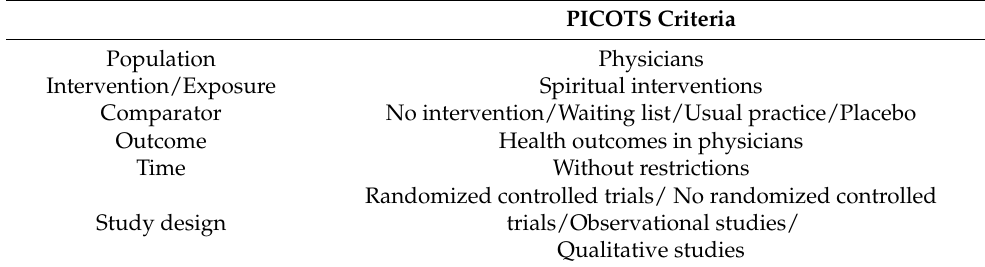
Table 2. PICOTS (population, intervention/exposure, comparator, outcome, time, and study design)